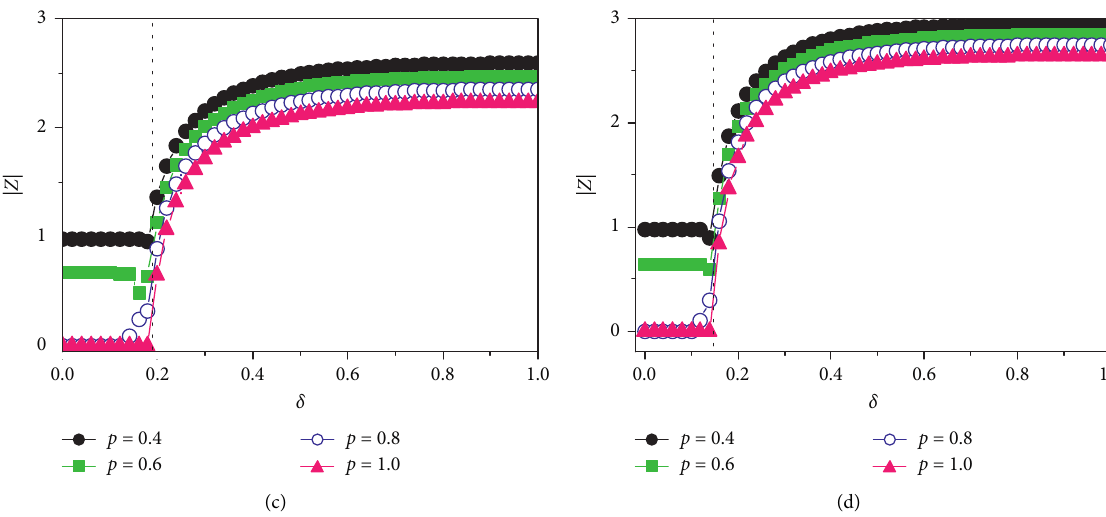
Figure 7: (a)–(d) The order parameter | Z | versus the time delay δ for κ � 2 . 0, 4.0, 6.0, and 8.0, respectively. In each figure, from top to bottom, p � 0 . 4, 0.6, 0.8, and 1.0,